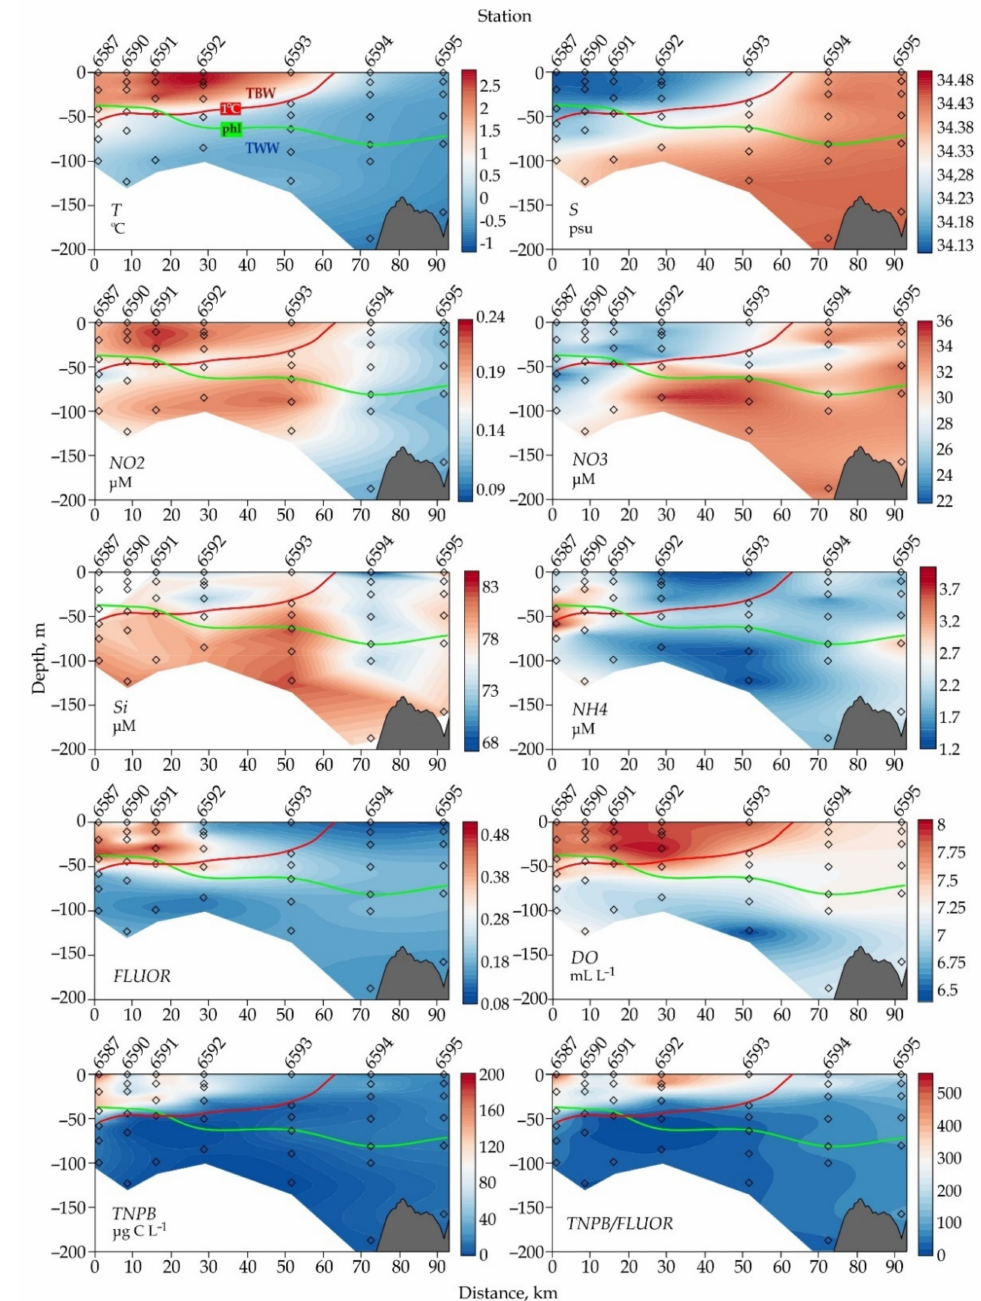
Figure 4. Vertical distribution of water temperature ( T ), salinity ( S ), nutrients ( NO2 , NO3 , NH4, Si ), dissolved oxygen ( DO ), Chl- a fluorescence ( FLUOR ), total nanophytoplankton biomass ( TNPB ), and TNPB/FLUOR ratio along the transect in the Bransfield Strait during austral mid-summer, January 2020. Green and red lines represent the bottom of the euphotic layer (phl) and 1 ◦ C isotherm (as a boundary between TBW and TWW; explanations are in the text), respectively. Description of the variables is given in Table